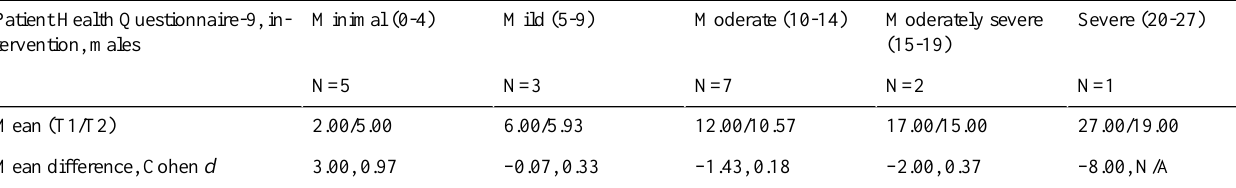
Table 8. Analysis of Patient Health Questionnaire-9 subgroups: